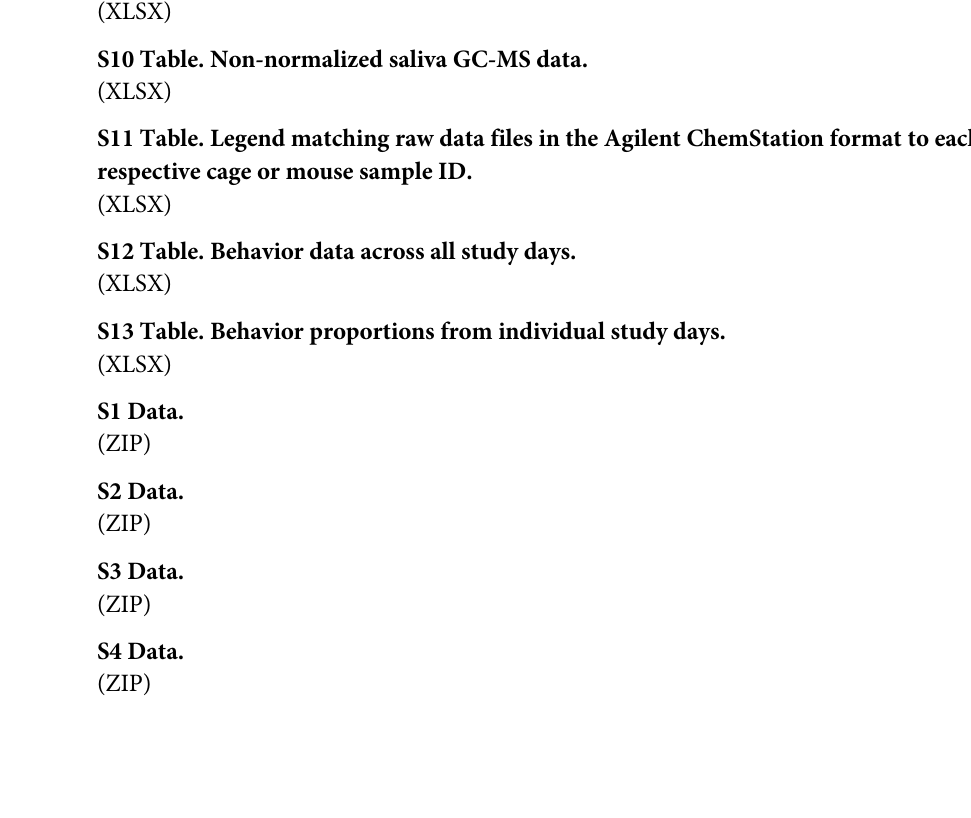
S8 Table. Non-normalized urine GC-MS data.